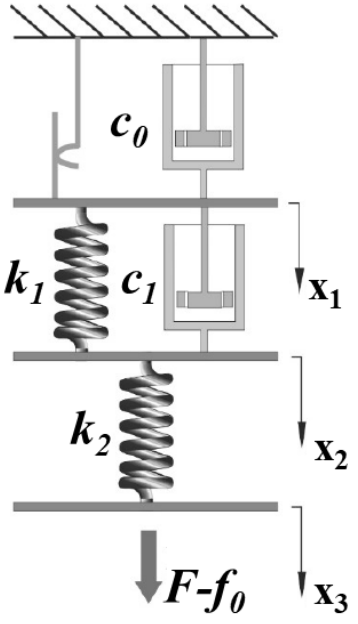
Figure 3. Gamota and Filisko model’s